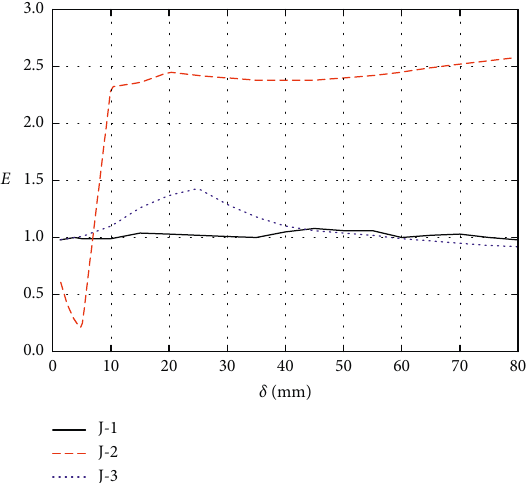
Figure 14: Comparison of the dissipative coefficient.